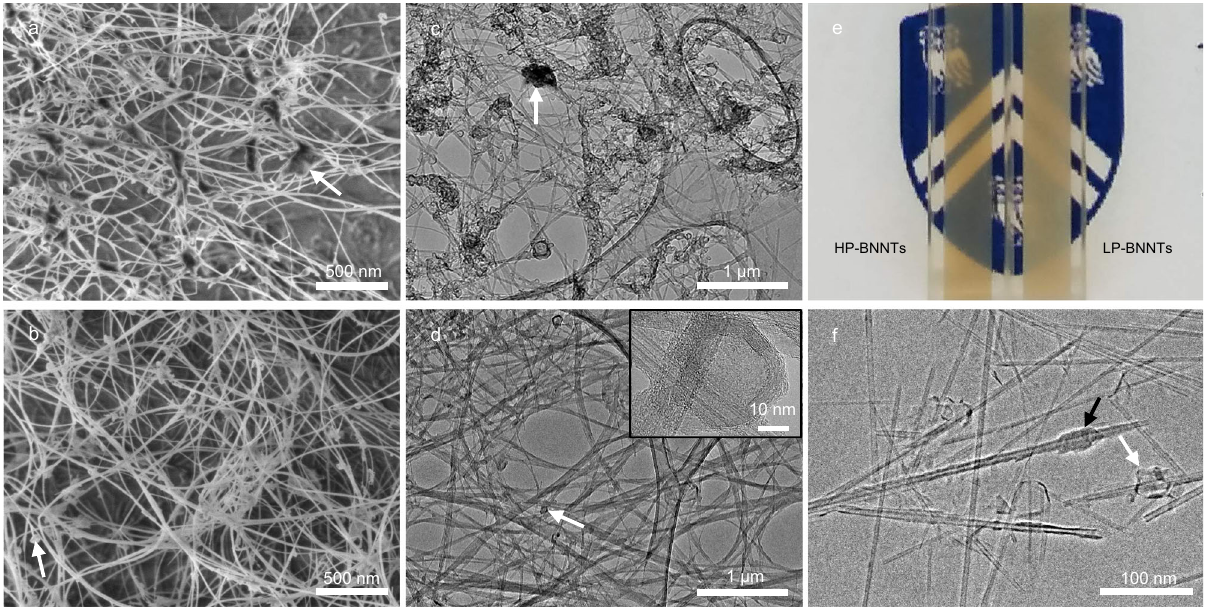
Fig. 1 Purity assessment of lightly puri fi ed BNNTs (LP-BNNTs) and highly puri fi ed BNNTs (HP-BNNTs). a Scanning electron microscopy (SEM) of LP- BNNTs. b SEM of HP-BNNTs. c Transmission electron microscopy (TEM) of LP-BNNTs on perforated carbon grid. d TEM of HP-BNNTs on perforated carbon grid with inset TEM image of residual contaminants in HP-BNNTs. A selected area fast Fourier transform of the inset image indicates an interlayer spacing of 0.337 nm, the same as for h-BN (Supplementary Fig. 4). Electron microscopy shows a reduction in non-nanotube structures upon more puri fi cation. Arrows indicate hexagonal boron nitride (h-BN) contaminants in both LP-BNNTs and HP-BNNTs. e Photograph of solutions of (left) HP- BNNTs and (right) LP-BNNTs in chlorosulfonic acid (CSA) at 1700 ppmw in 4 mm path length quartz cuvettes placed in front of the Rice University shield. Scattering of the LP-BNNT solution occludes details in the design. f Cryogenic-TEM of 4000 ppmw HP-BNNTs in CSA showing amorphous material covering BNNTs (black arrow), and faceted structures (white arrow). Table 1 Summary of bootstrapped HP-BNNT